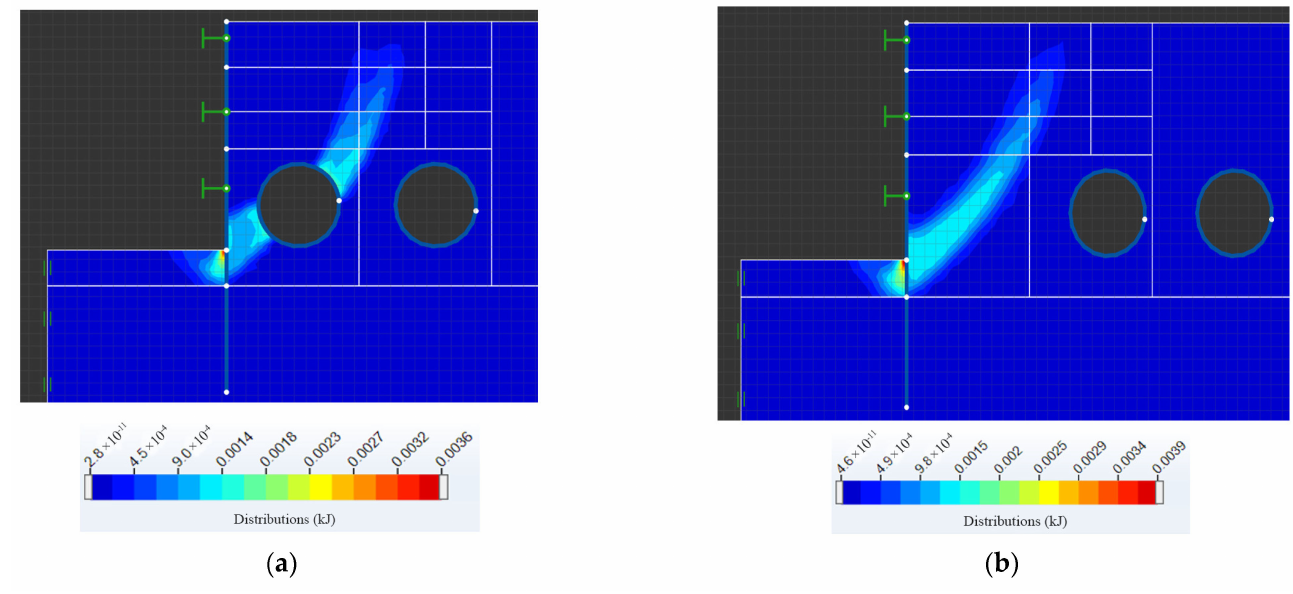
Figure 15. Shear dissipation contours under different horizontal distance L in stage (4): ( a ) L = 0.33 H and ( b ) L = 1.0 H.